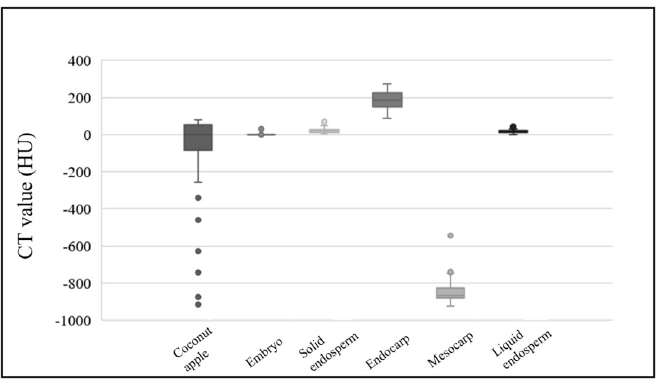
Fig 6. Computed tomography values for each component of